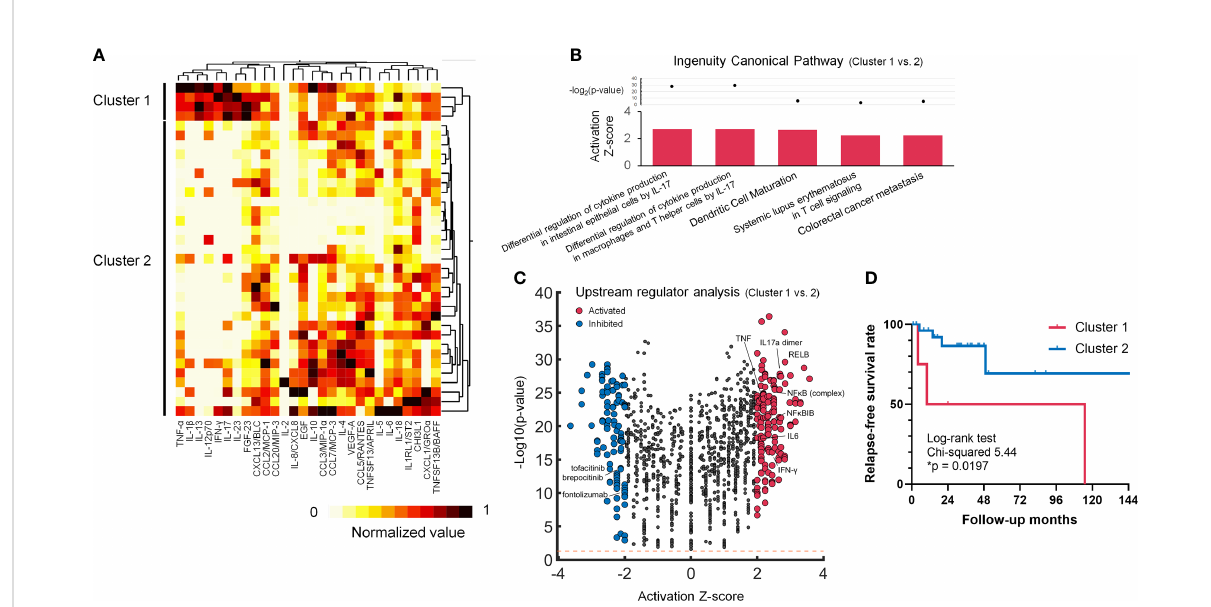
FIGURE 2 Cluster analysis in untreated LVV patients, revealing the activating IL-17 phenotype with frequent relapse. (A) Cluster heatmap of blood 28 cytokines/chemokines data of the normalized concentration values. (B) Volcano plot displaying signi fi cant regulators predicted by Ingenuity Pathway Analysis for Cluster 1 LVV patients in comparison with Cluster 2. The y-axis corresponds to the value of -log 10 (p-value), and the x-axis displays the activation Z-score value. The red dots represent the predictably activated regulators or the blue dots inhibited. Positive x-values represent probable activation and negative probable inhibition. The Orange horizontal line denotes p-value of 0.05. (C) Ingenuity canonical pathways with the prediction of its activated pathway in Cluster 1 vs. Cluster 2 LVV patients. (D) Kaplan-Meier survival curve regarding relapse free survival rate during the time from the initial diagnosis to the fi rst documented disease relapse. The LVV patients in Cluster 1 (red) demonstrated a higher relapse survival rate (*p < 0.05) than those in Cluster 2 (blue) using Log-rank test. The ticks indicate censored